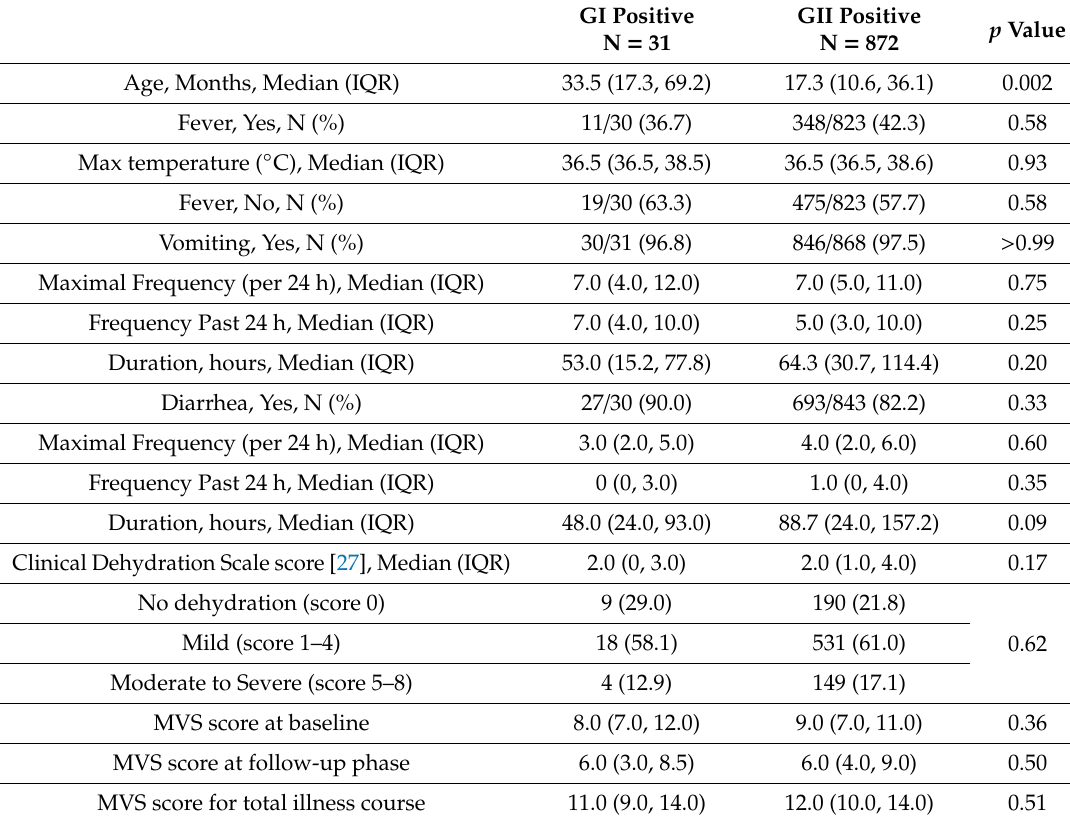
Table 2. Clinical characteristics of Norovirus GI and GII Genogroups.